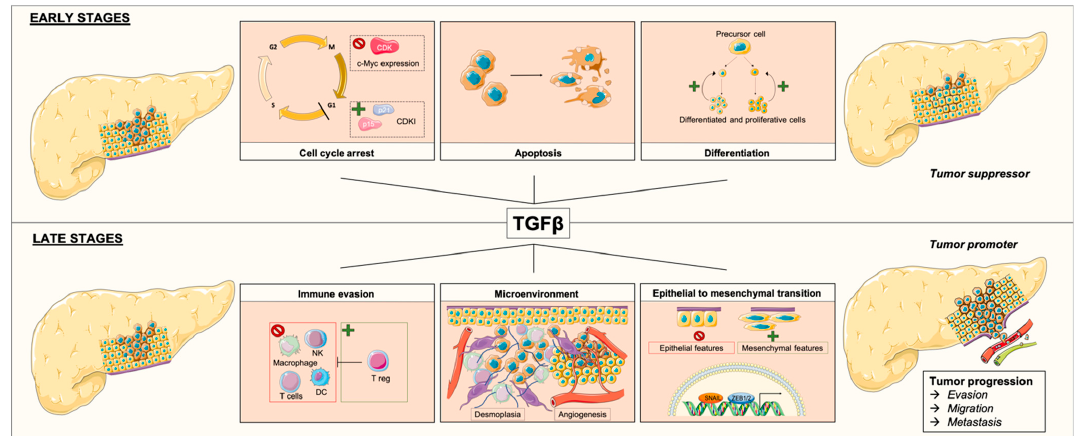
Figure 2. Effects of TGF β depending of pancreatic ductal adenocarcinoma stages. At early stages, TGF β acts as a tumor suppressor, by promoting cell-cycle arrest through repression of c-Myc expression and cyclin-dependent kinase (CDK), and through enhancement of CDK inhibitor (CDKI) expression, thereby enhancing apoptosis and stimulating differentiation of precursor cells into a less proliferative stage. At late stages, TGF β acts as a tumor promoter through immune evasion by stimulation of regulatory T cells and by inhibition of natural killers (NKs), macrophages, T cells, and dendritic cells (DCs). TFG β acts also on the microenvironment by promoting desmoplasia and angiogenesis, and it triggers epithelial-to-mesenchymal transition (EMT) through induction of expression of transcription factors Snail and Zeb1/2.